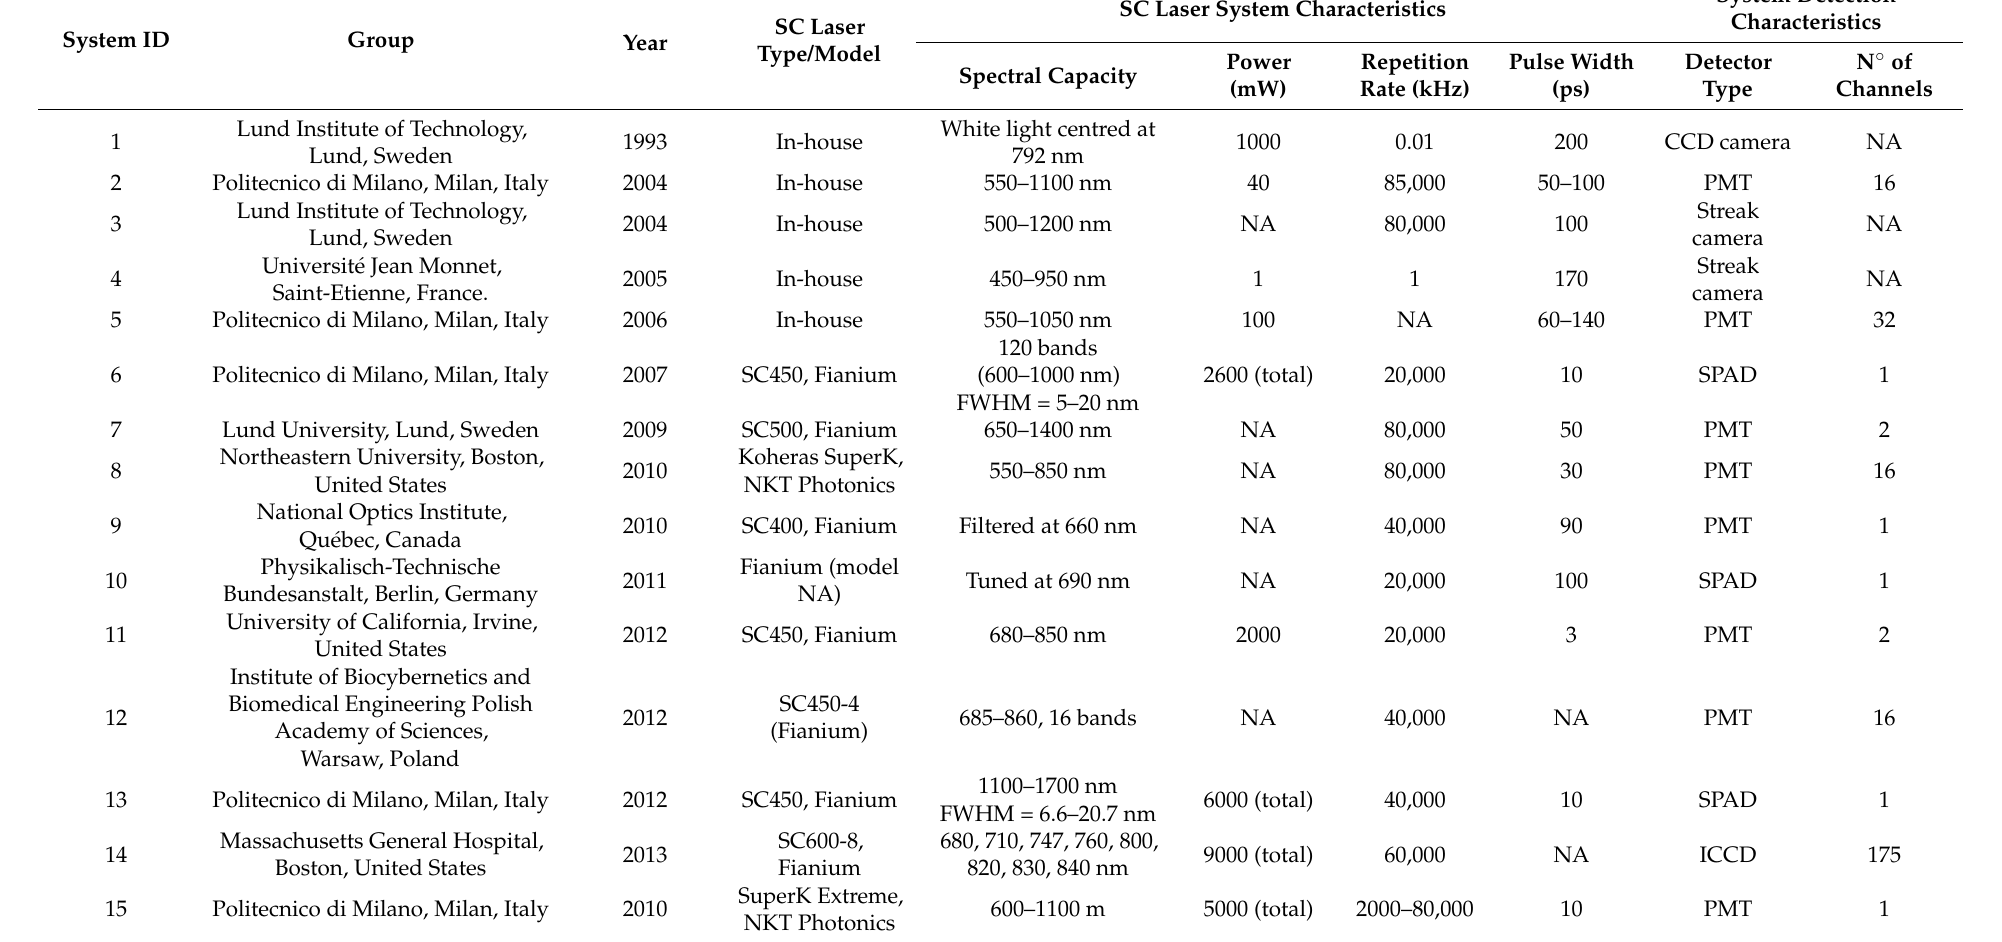
Table 1. List of the SC laser-based systems used in the publications reviewed, with their principal characteristics. SC: SuperContinuum, FWHM: Full Widht at Half Maximum, CCD: Charge-Coupled Device, ICCD: Intensified Charge-Coupled Device, PMT: PhotoMultiplier Tube, SPAD: Single-Photon Avalanche Diode, SiPM: Silicon PhotoMultiplier, HPM: Hybrid Photodetector Module, sCMOS: scientific Complementary Metal–Oxide–Semiconductor, NIR: Near